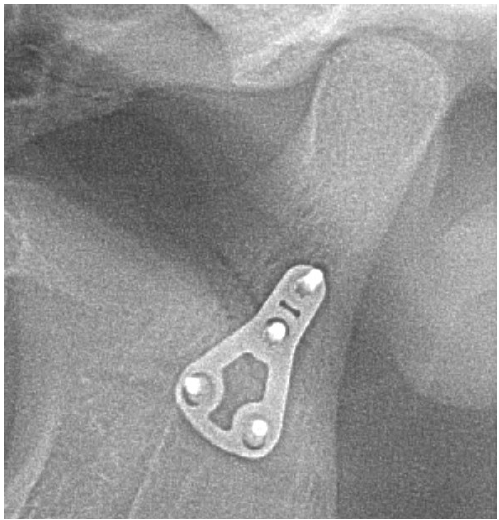
Figure 12. Patient A—An uncomplicated case—6 months after the surgery.